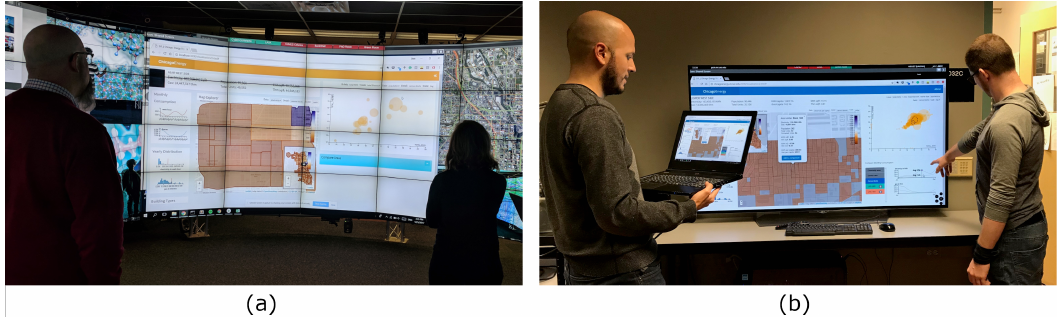
Figure 6. Energy explorer usage on a variety of displays and with different stakeholders. ( a ) Data analysts usage in a conference room equipped with a large tiled display. ( b ) Citizen usage on a laptop and a large